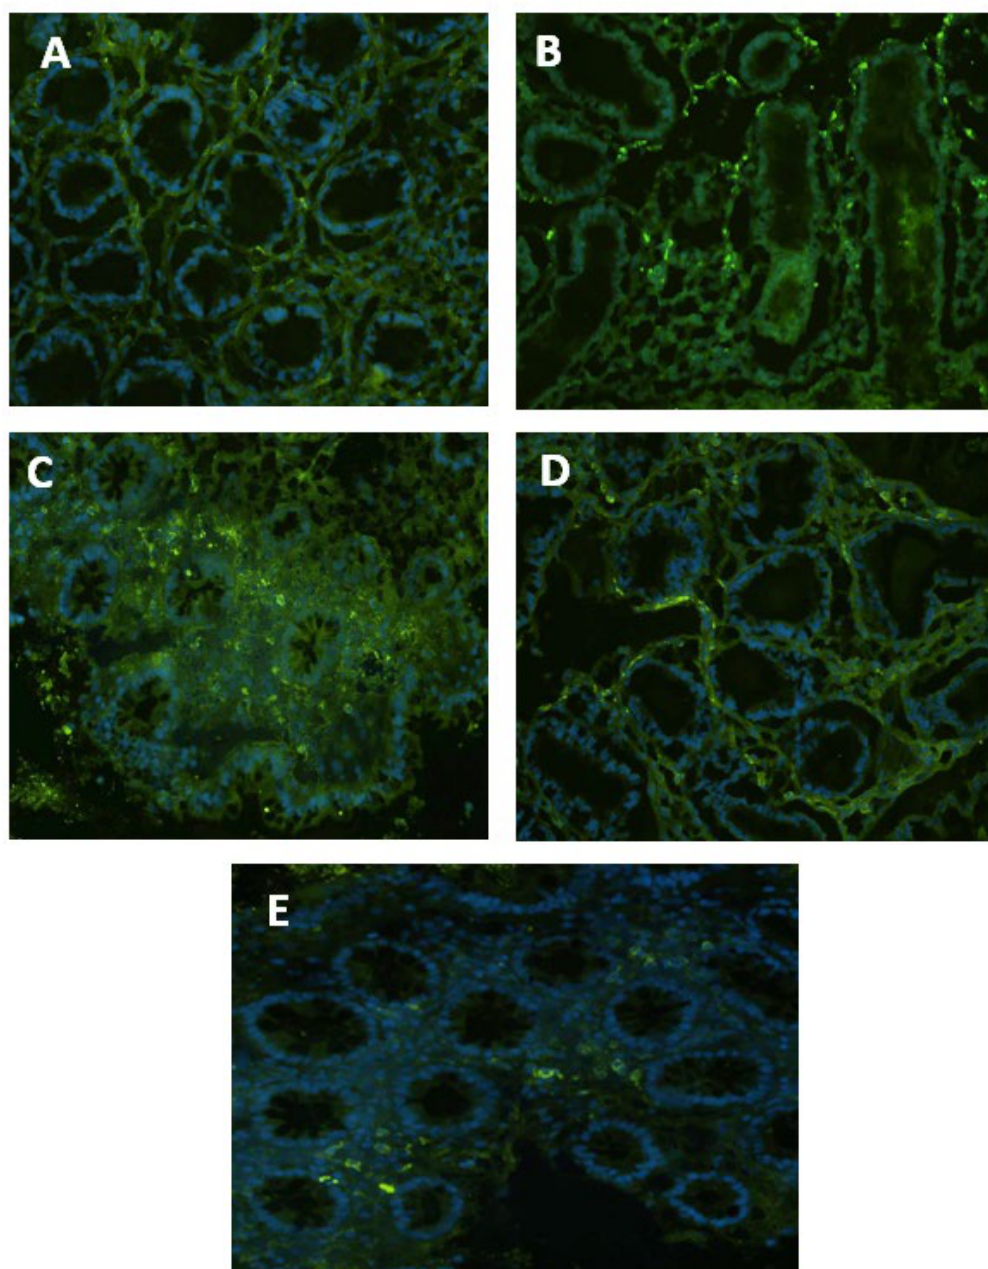
Figure 2. GAAE pre- treatment effect on COX -2 expression in normal controls challenged with EC-LPS. ( A ) No treated biopsy; ( B ) biopsy challenged with 1 µ g/mL EC-LPS for 18 h; ( C ) biopsy EC-LPS. ( A ) No treated biopsy; ( B ) biopsy challenged with 1 µg/mL EC - LPS for 1 8 h ; ( C ) biopsy pretreated 3 h with 50 µg/mL GAAE , then challenged with 1 µg/mL EC - LPS for 1 8 h ; ( D ) biopsy pretreated 3 h with 50 µ g/mL GAAE, then challenged with 1 µ g/mL EC-LPS for 18 h; ( D ) biopsy pretreated 3 h with 100 µg/mL GAAE , then challenged with 1 µg/mL EC - LPS for 1 8 h ; ( E ) biopsy pretreated 3 h with 100 µ g/mL GAAE, then challenged with 1 µ g/mL EC-LPS for 18 h; ( E ) biopsy pretreated only with 100 µg/mL GAAE for 21 h . pretreated only with 100 µ g/mL GAAE for 21